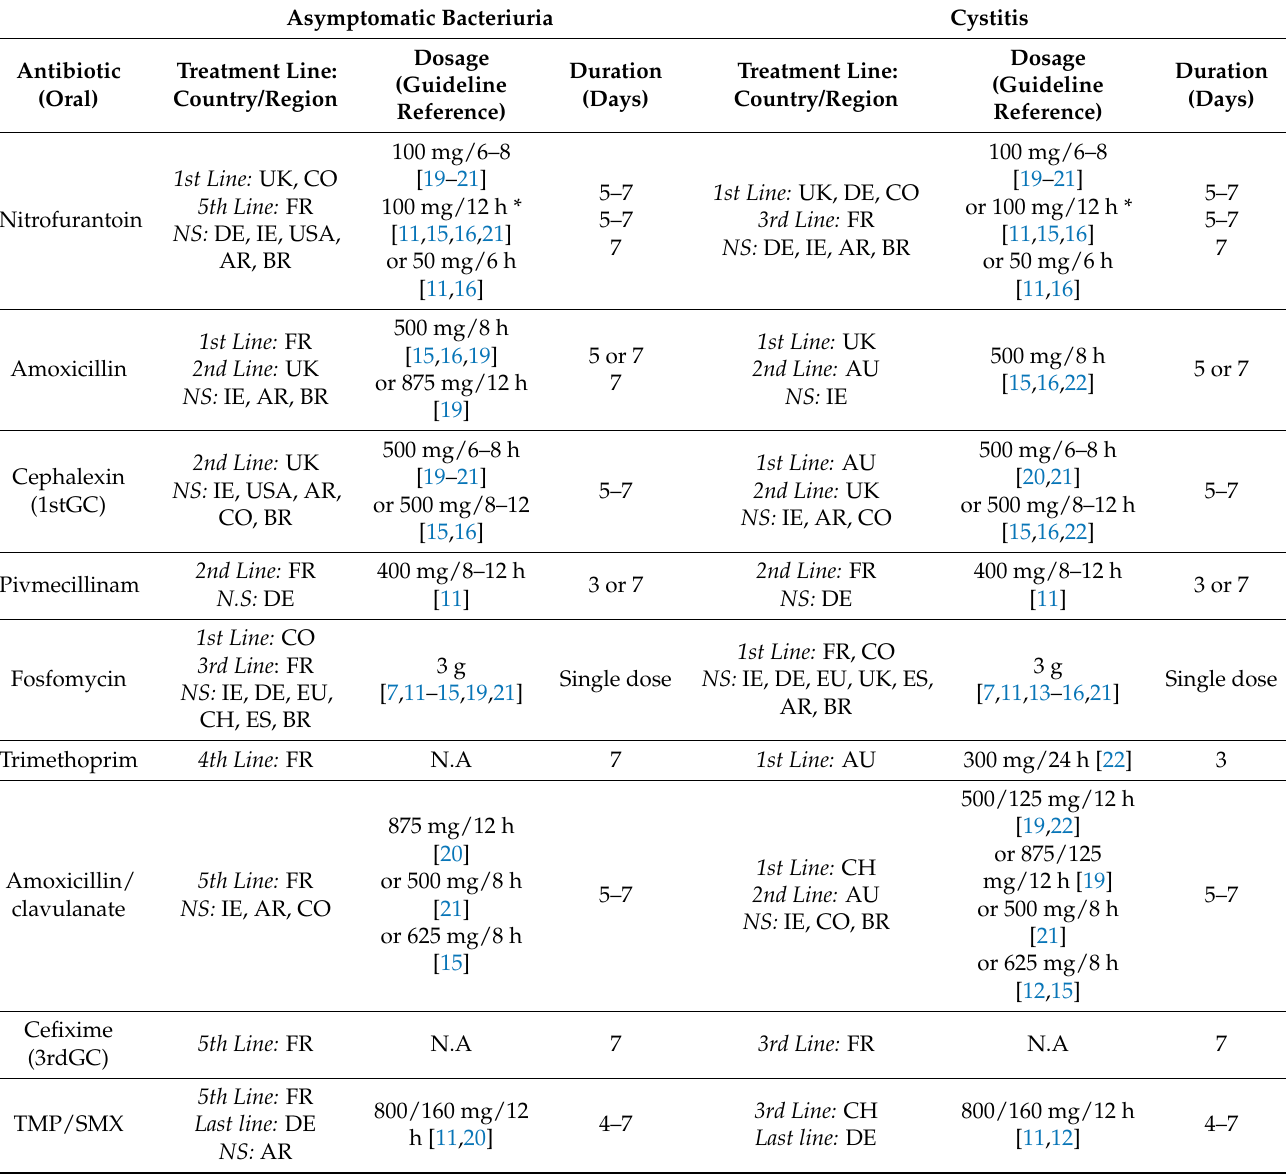
Table 3. Antibiotic treatment for asymptomatic bacteriuria and cystitis during pregnancy. Asymptomatic Bacteriuria